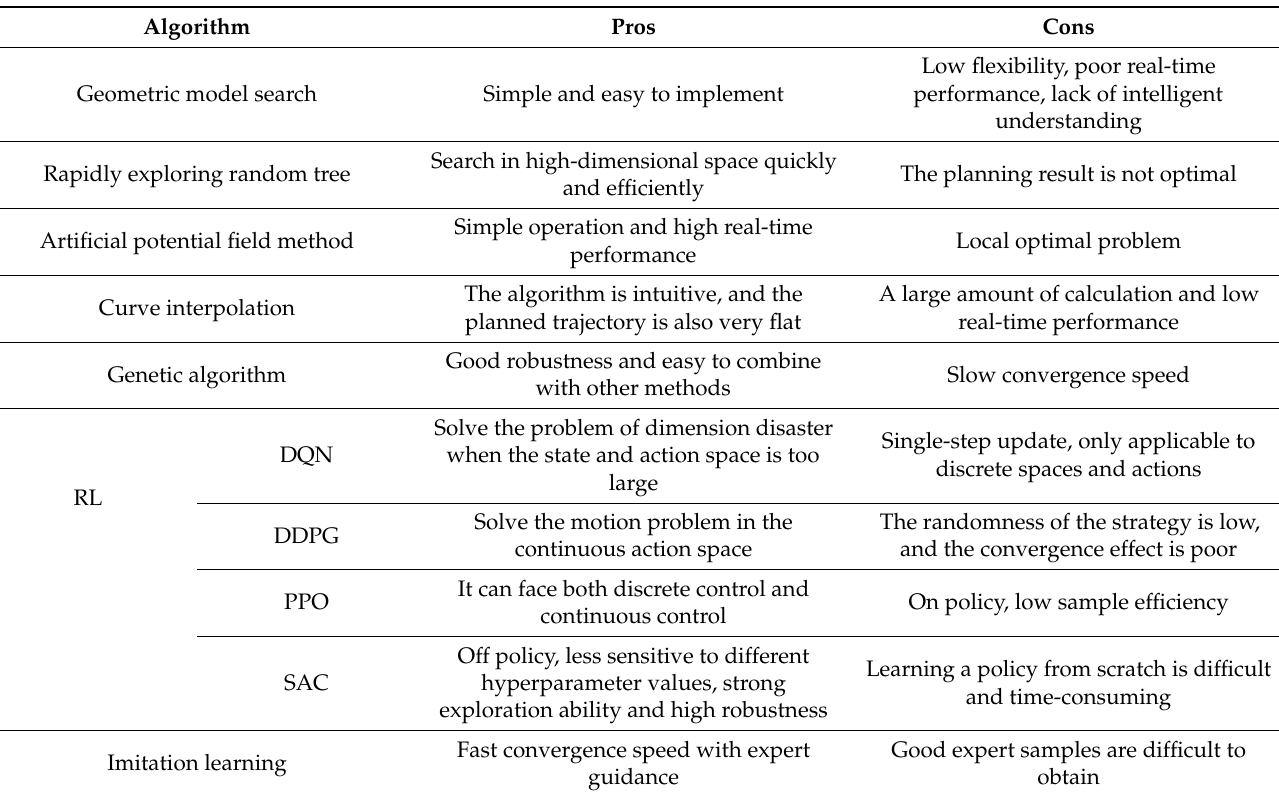
Table 1. The pros and cons of several